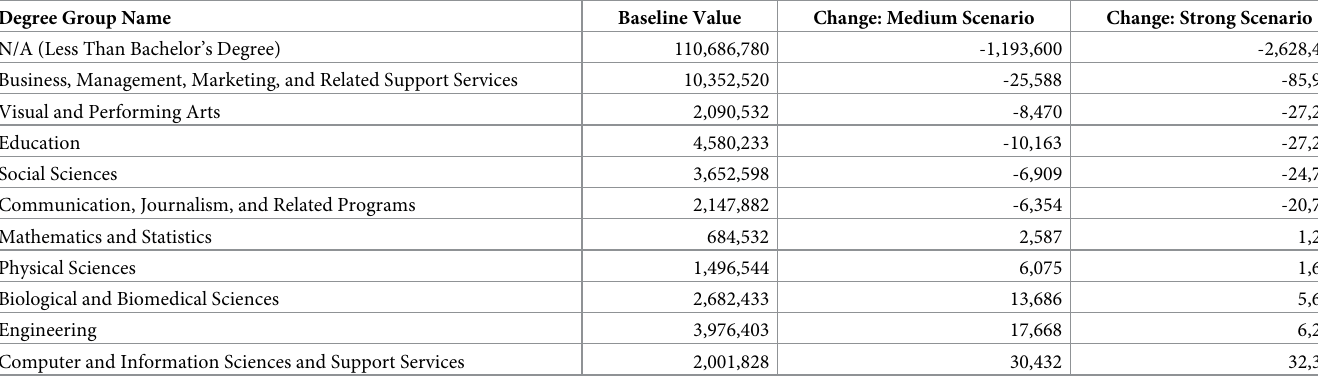
Table 6. Projected changes in total workers by degree group.